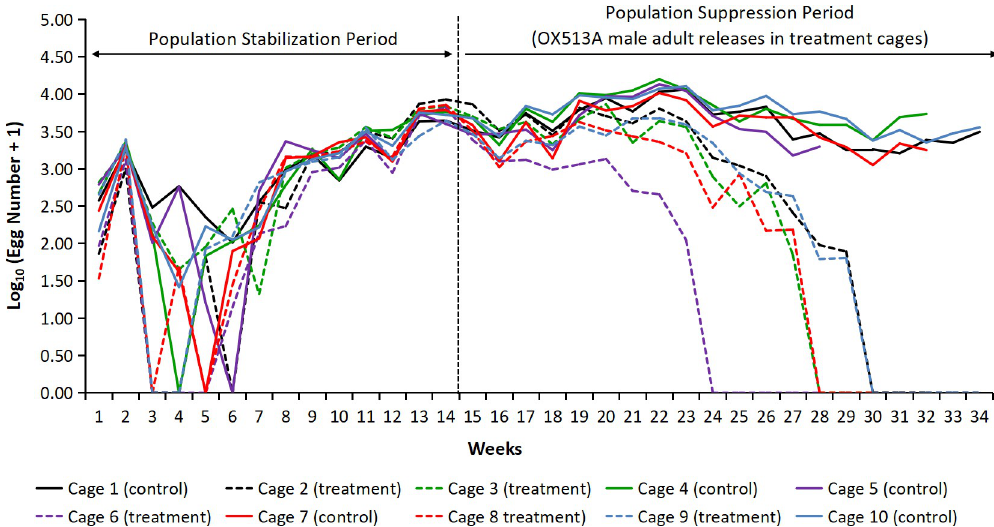
Fig 2. Weekly egg production in control and treatment cages during experiment. Egg production number increased from week 9 reflecting establishment and stable adult mosquito population during subsequent weeks in all cages. Post establishment, OX513A male adult releases weekly were initiated (weekly 15 onwards) (vertical dashed line) in the all 5 treatment cages. https://doi.org/10.1371/journal.pntd.0010315.g002 Weekly larval return rate in treatment cages for cage 2 and 3 was high during the first two weeks (i.e. week 15 and 16) post OX513A release initiation, corresponding to the egg produc- tion rate and gradually decreased in the subsequent weeks. In cage 6, 8 and 9 the larval return